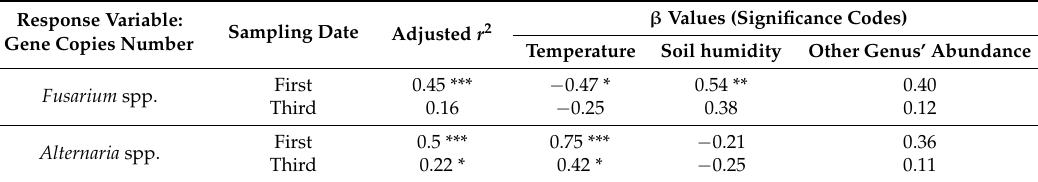
Table 5. Results of the fitted multiple linear models. As response variables, the genetic abundances were taken (transformed logarithmically), explained with microclimatic variables. A multiple linear model was fitted per sampling date, for a total of four models. (Significance codes: *** p <